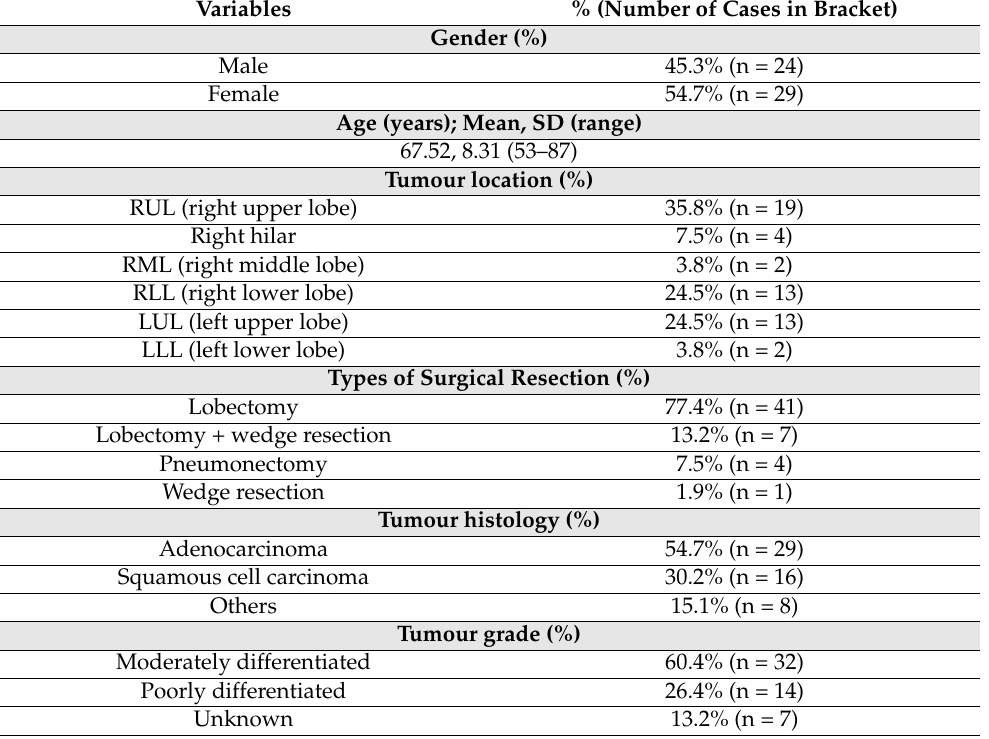
Table 1. Clinico-pathologic characteristics of patients (7 patients did not have tumour grade recorded while 8 tumours were of less common histology type; these are grouped as ‘others’). Variables % (Number of Cases in Bracket) Gender